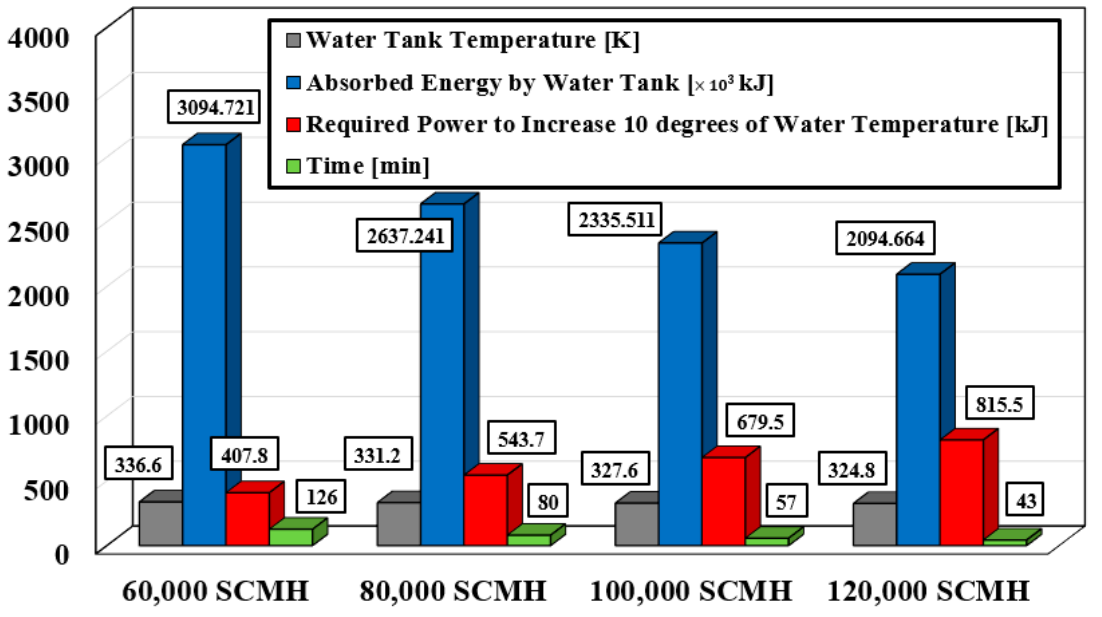
Figure 19. The burner off time versus the gas mass flow rate needed to maintain a temperature of 20 degrees for the gas coil output.